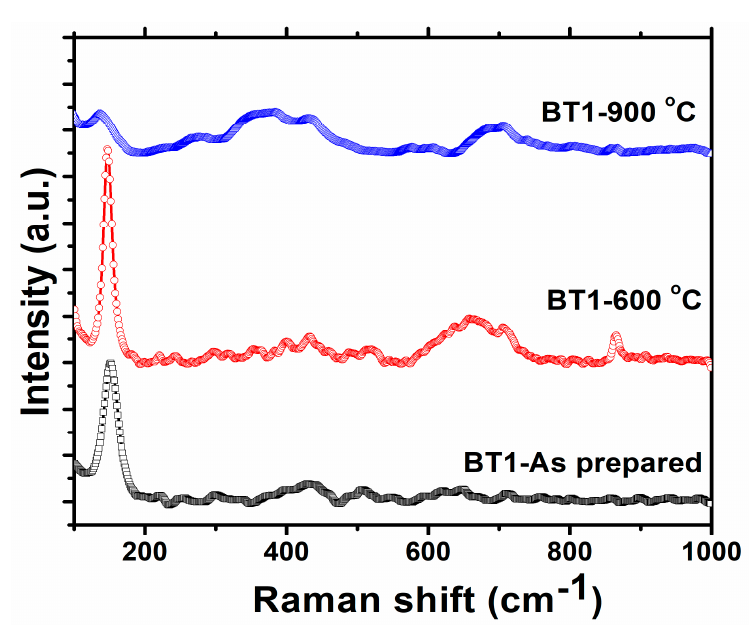
Figure 5. Raman spectra of BT1 sample calcined at different temperatures.